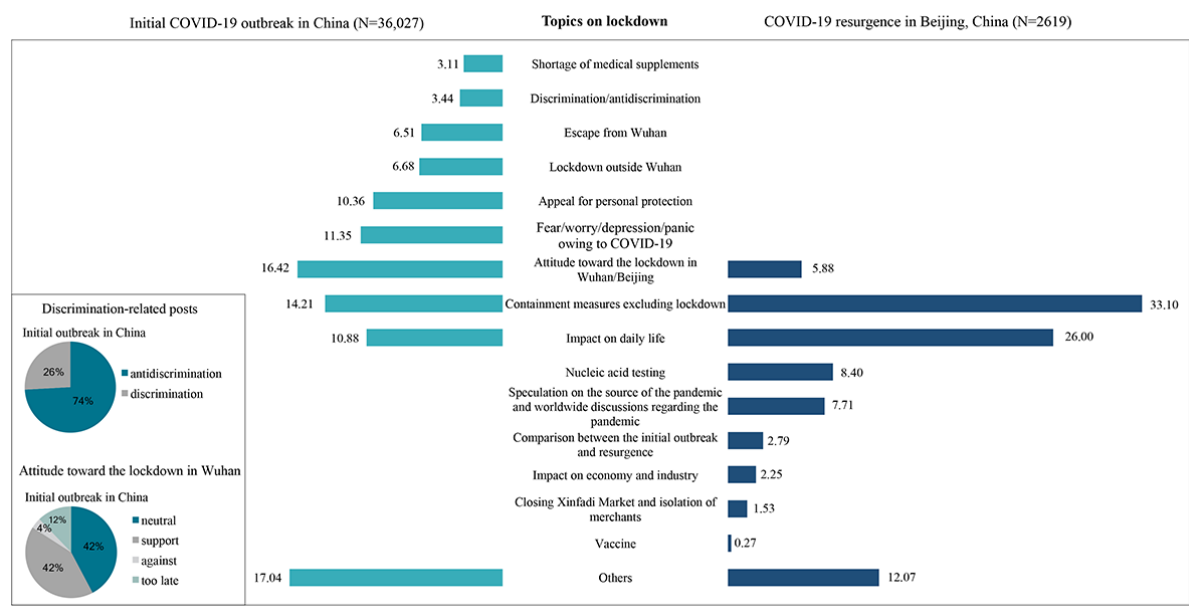
Figure 4. Proportion of posts related to frequently discussed topics on the lockdown measure during the initial outbreak and the resurgence of COVID-19 in China. The columns show the proportion of posts on each topic among all posts related to the lockdown measure. Pie charts show the proportion of various attitudes toward some topics during the initial